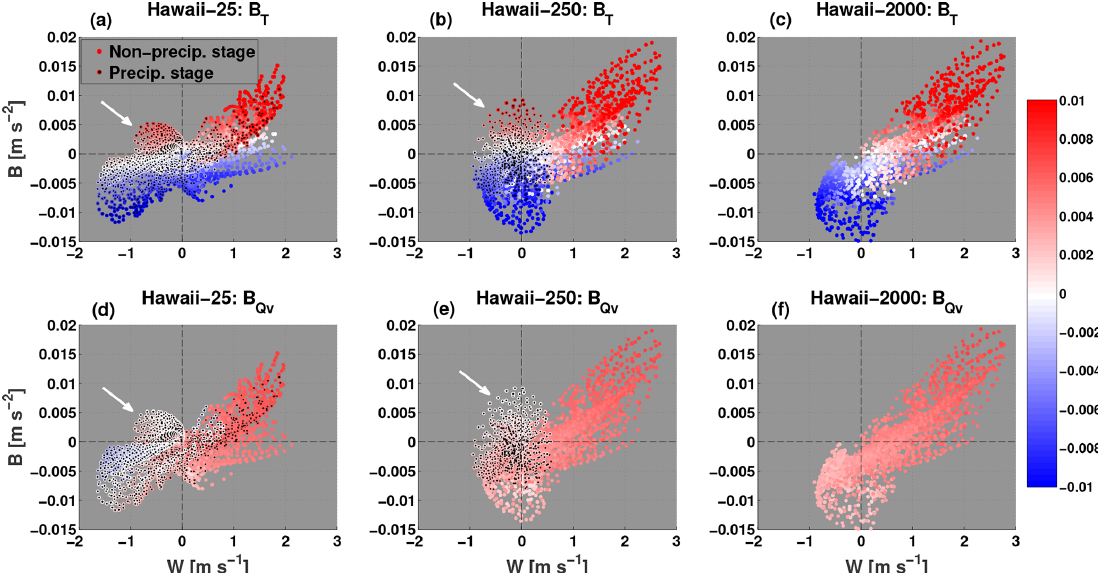
Figure 2. Scatterplots of pixel total buoyancy (ms − 2 ) vs. pixel vertical velocity (ms − 1 ) for the clean (a, d) , intermediate (b, e) , and polluted (c, f) simulations. Data include all cloudy pixels during all time steps. Colors represent magnitude of buoyancy temperature term ( B T ; a, b, c ) and humidity term ( B Qv ; d, e, f ), where red (blue) shades indicate positive (negative) values. Markers with superimposed black dots represent temporal stages with non-zero surface precipitation. White arrows indicate outlier scatter of pixels with positive buoyancy and negative vertical